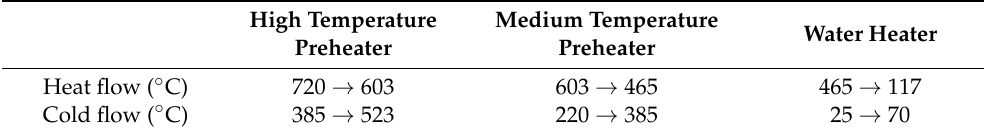
Table 2. Heat exchanger temperature parameters.